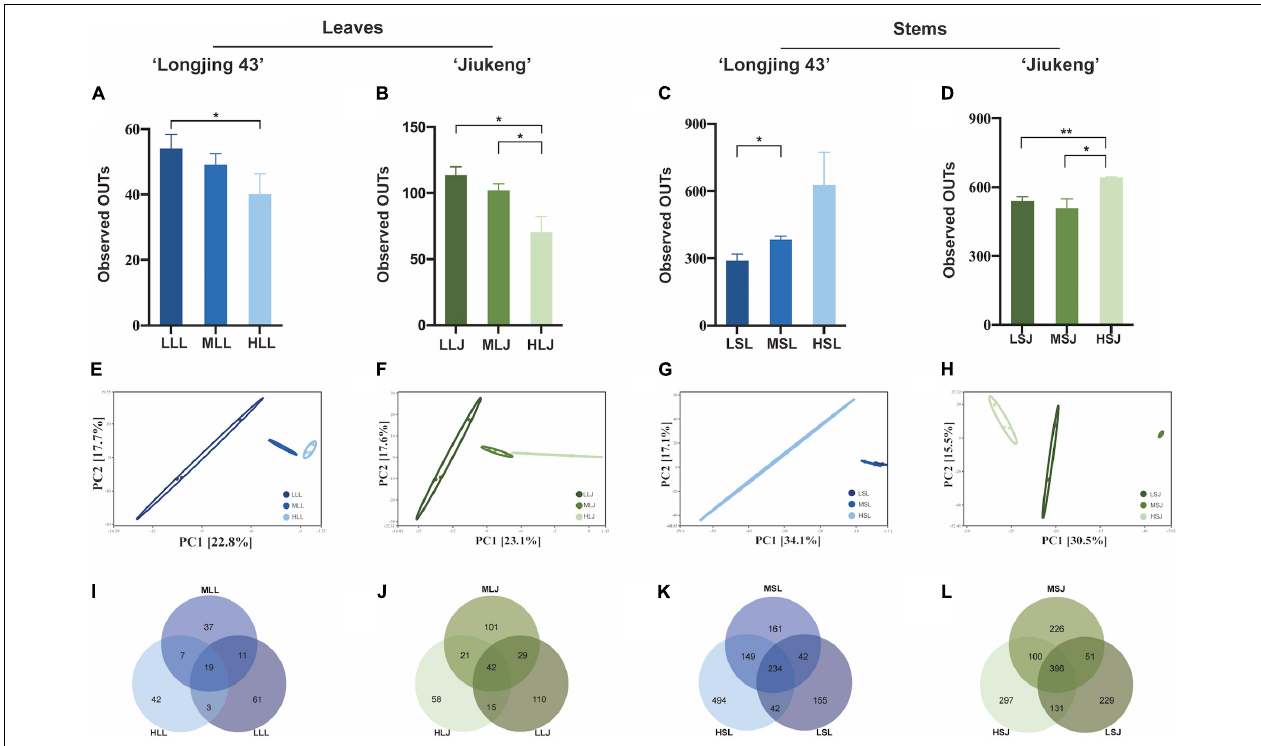
FIGURE 3 | Effects of sterilization treatments on the diversity of bacterial endophytes from tea plant leaves and stems. (A–D) Alpha diversity of the bacterial endophytic community; (E–H) principal component analysis (PCA) of the bacterial community structure; (I–L) Venn diagram showing the number of shared and unique OTUs (at 97% similarity). LLL, MLL, and HLL represent the leaf samples from cultivar Longjing 43 treated with 0.5, 1.0, and 2.0% of NaClO. LLJ, MLJ, and HLJ represent the leaf samples from the cultivar Jiukeng treated with 0.5, 1.0, and 2.0% of NaClO. LSL, MSL, and HSL represent the stem samples from the cultivar Longjing 43 treated with 0.5, 1.0, and 2.0% NaClO. LSJ, MSJ, and HSJ represent the leaf samples from the cultivar Jiukeng treated with 0.5, 1.0, and 2.0% NaClO. Asterisks indicate significant differences (* p < 0.05 and ** p <